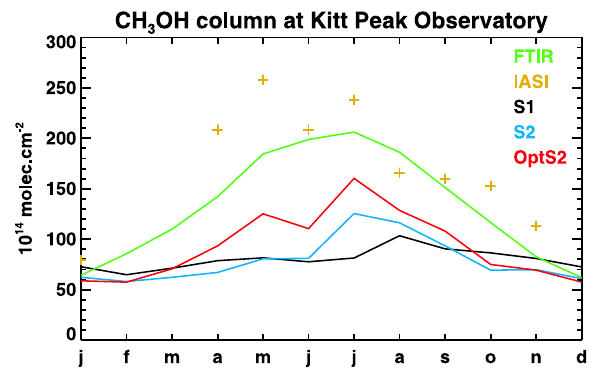
Fig. 12. Comparison between (1) monthly averaged FTIR data obtained at the Kitt Peak Observatory (31.9 ◦ N, 111.6 ◦ W, 2.09-km asl) with a 1-m Fourier transform spectrometer between October 1981 and December 2003 (Rinsland et al., 2009) (in green), (2) IASI columns (in orange), (3) columns simulated by S1, S2 and OptS2 between 2.04 and 14 km. The total uncertainty in the 2.09-14-km FTIR methanol columns due to both random and systematic errors is estimated at less than 20% (Rinsland et al., 2009). The correlation coefficient between the model and the FTIR data is equal to 0.55 in S1, 0.8 in S2, and 0.94 in OptS2 inversion.